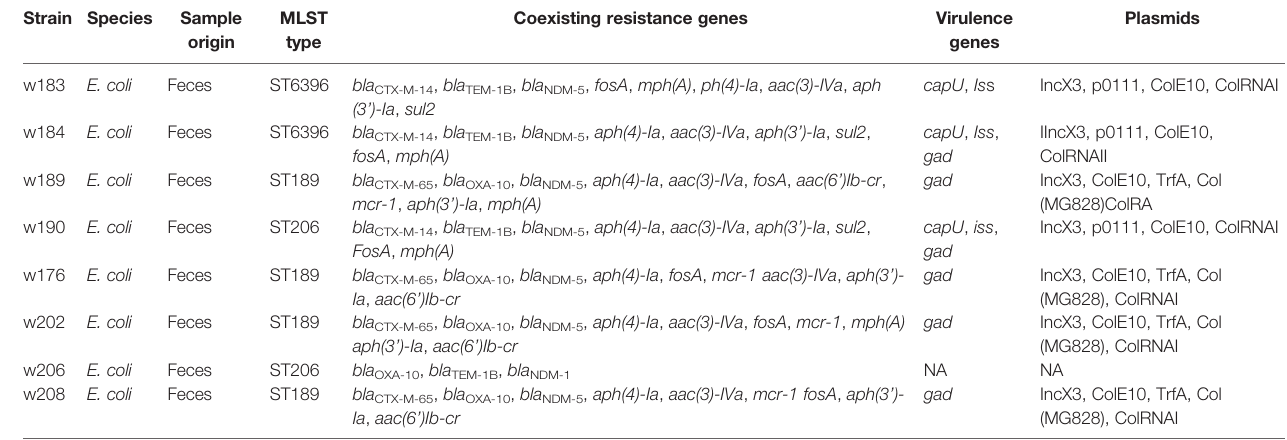
TABLE 2 | Information for the eight bla NDM -positive Escherichia coli isolates identi fi ed in the current study. Strain